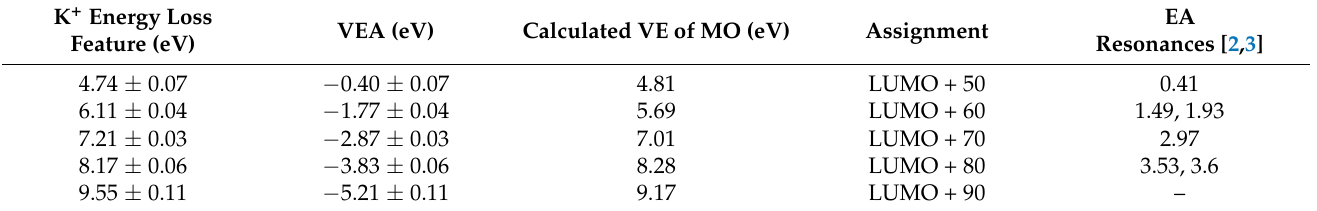
Table 2. Assignment of different features from the Gaussian fitting to K + energy loss spectrum from potassium collisions with NIMO at 205 eV lab frame energy (157 eV in the center-of-mass frame). VEA (Vertical Electron Affinity), VE (Vertical Energy), EA (Electron Attachment) *.